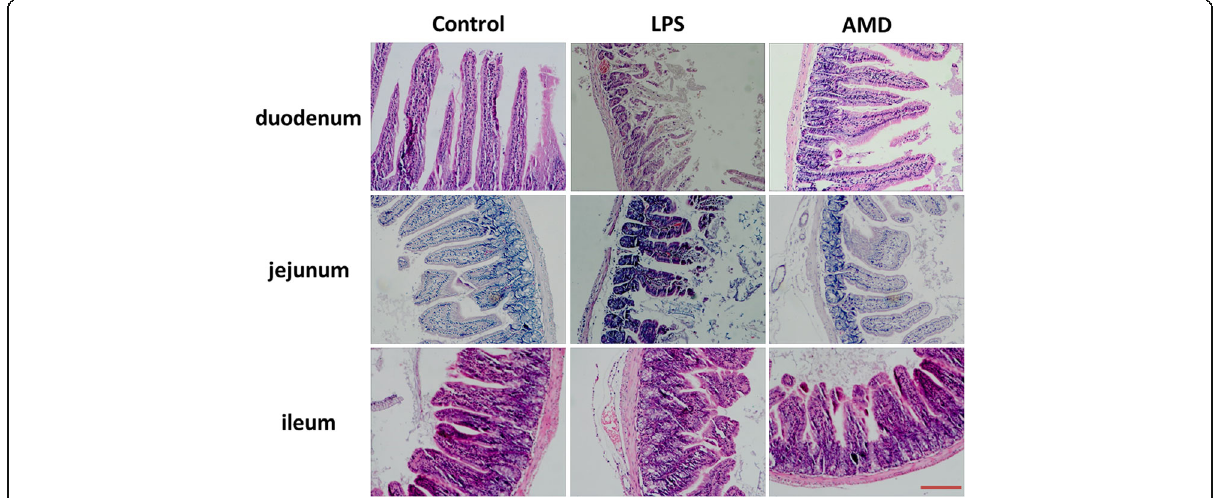
Fig. 2 Histomorphometric analyses of intestinal mucosa time changes. Histological appearance of mice intestinal mucosa after haematoxylin and eosin (H&E) stain (original magnification 100×). Scale bars: 50 μ